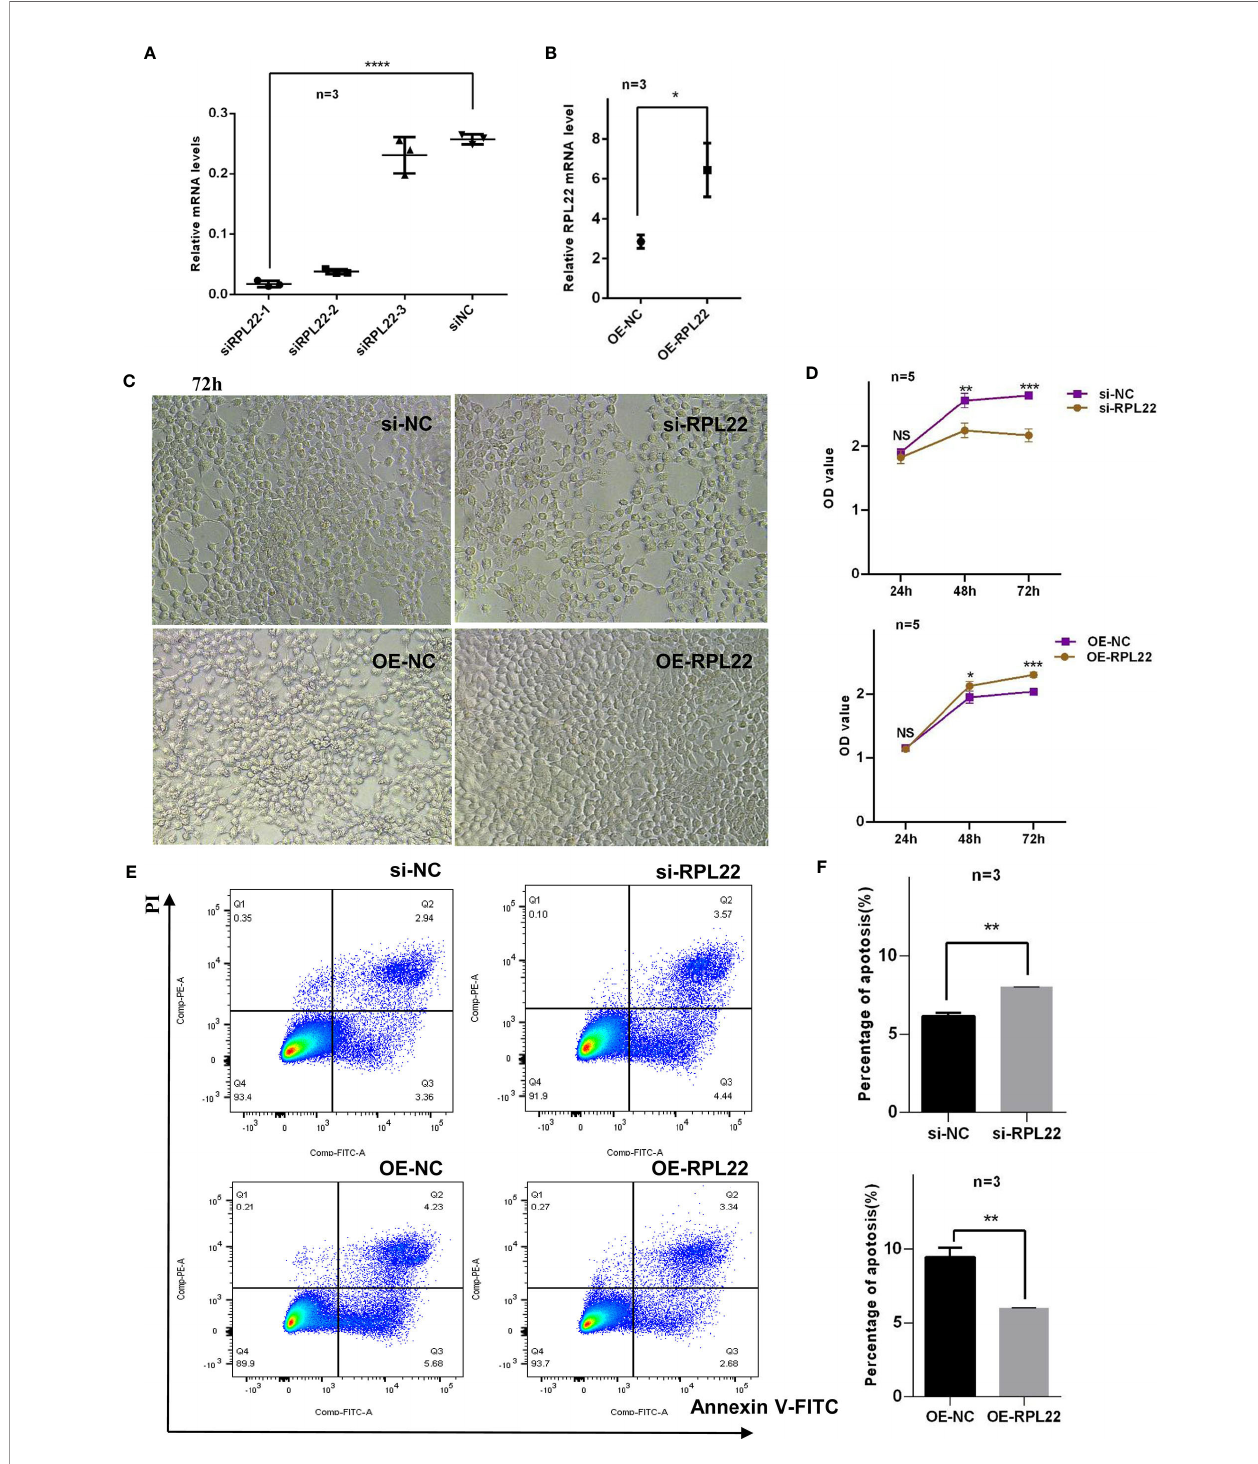
FIGURE 3 | RPL22 promotes the proliferation of HaCaT cells and inhibits apoptosis of KCs. (A) Selection and veri fi cation of RPL22 siRNA intervention ef fi ciency in HaCaT cells (n = 3). (B) Overexpression ef fi ciency veri fi cation of RPL22 overexpressed plasmid (OE-RPL22) in HaCaT cells (n = 3). (C) Microscopy to observe cell proliferation state in HaCaT cells at 72hours. (D) CCK-8 assay to detect the cell proliferation level in HaCaT cells transfected with si-RPL22 or OE-RPL22 and their controls. (E) Flow cytometry to detect the apoptosis of KCs transfected with si-RPL22 or OE-RPL22 and their controls (n = 3). (F) Statistical analysis data to show the difference of four groups at 48 hours. All data are representative of at least 3 independent experiments. Data represent the mean ± SEM. *P < 0.05, **P < 0.01, ***P < 0.001, ****P < 0.0001. NS, not signi fi cant. Two-tailed unpaired Student ’ s t test was